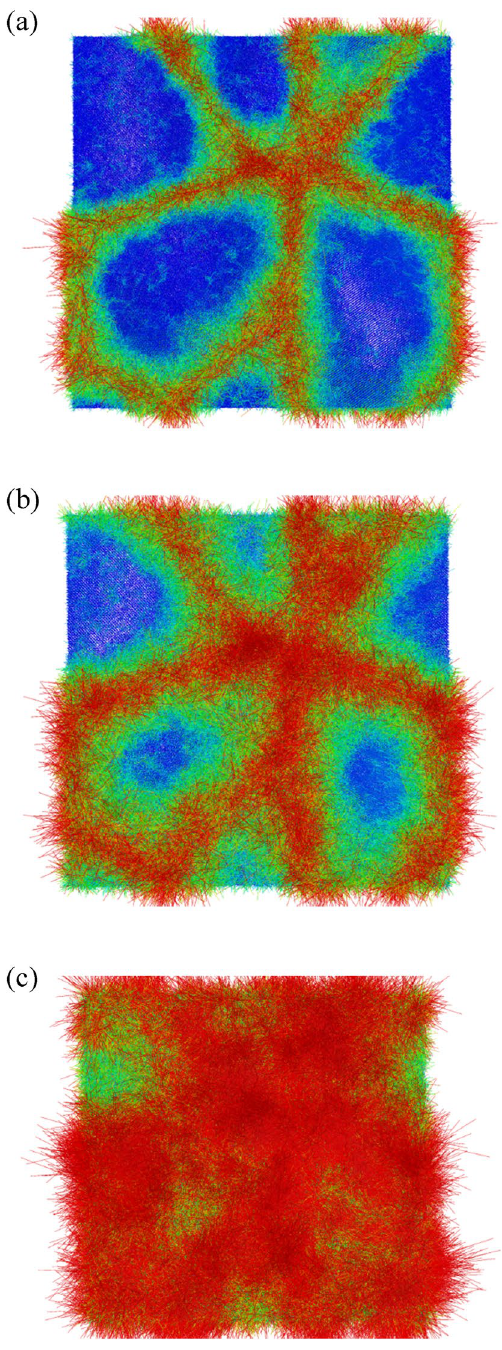
Figure 14. The atomic displacement vectors of 25.3 nm at ( a ) 2820 K, ( b ) 2920 K, and ( c ) 3100 K, respectively. The atom positions at 300 K were used as the reference positions for the displacement